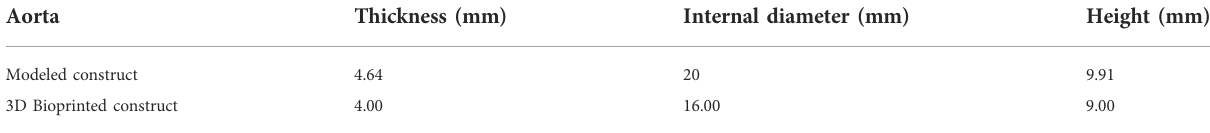
TABLE 1 Comparison between the modeled (geometrical model) and the 3D bioprinted construct main geometrical dimensions.